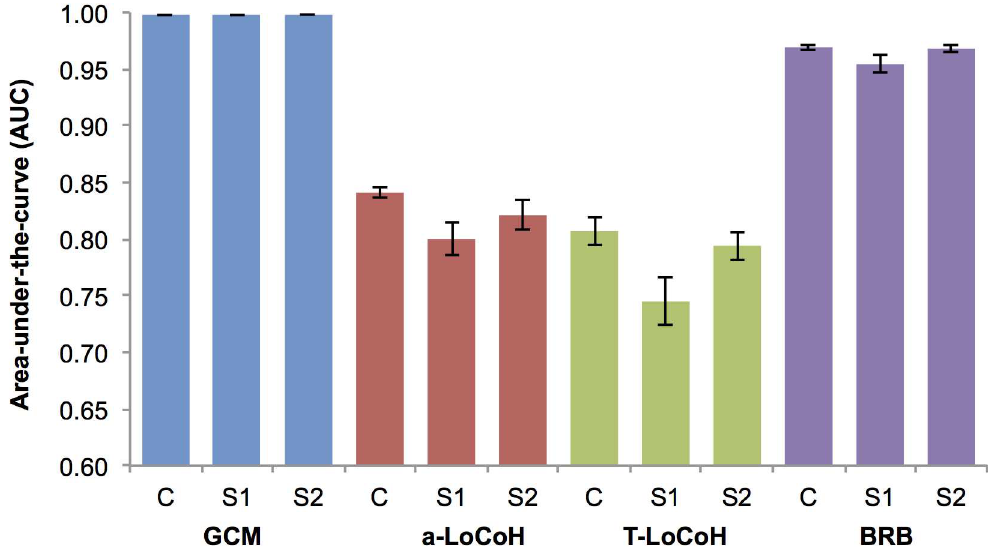
Fig 3. Mean ( ± SE) area-under-the-curve for the home range estimators (N = 10 individuals). Grid-cell method (GCM—blue), adaptivelocal convex hull ( a -LoCoH—red), adaptivetime local convex hull (T-LoCoH— green) and biasedrandom bridges(BRB—purple), using the completedata set (C) and the simulatedscenarios, with a decreased samplinginterval (S1 = fixes every 4 hours), and simulatingrandomfailures (S2).